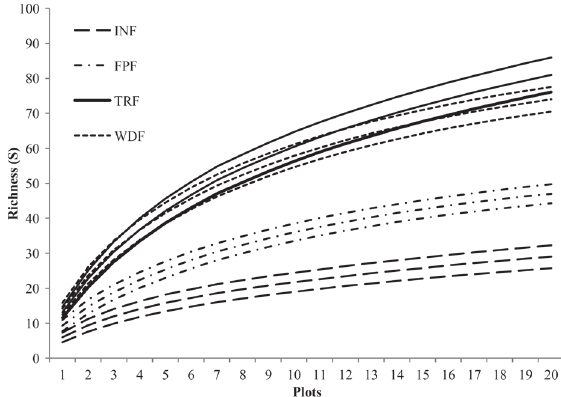
Figure 3 - Mao Tao rarefaction curves for the four forest formations in Jacarenema Natural Municipal Park, Vila Velha/ES. INF=Inundated Forest; FPF=Floodplain Forest; TRF=Transitional Forest; WDF=Well- drained